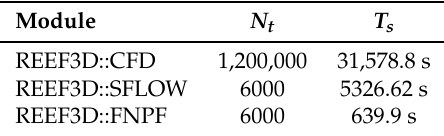
Table 6. Comparison of total number of cells N t and simulation time T s in seconds for the simulation of wave propagation over a submerged bar using the three